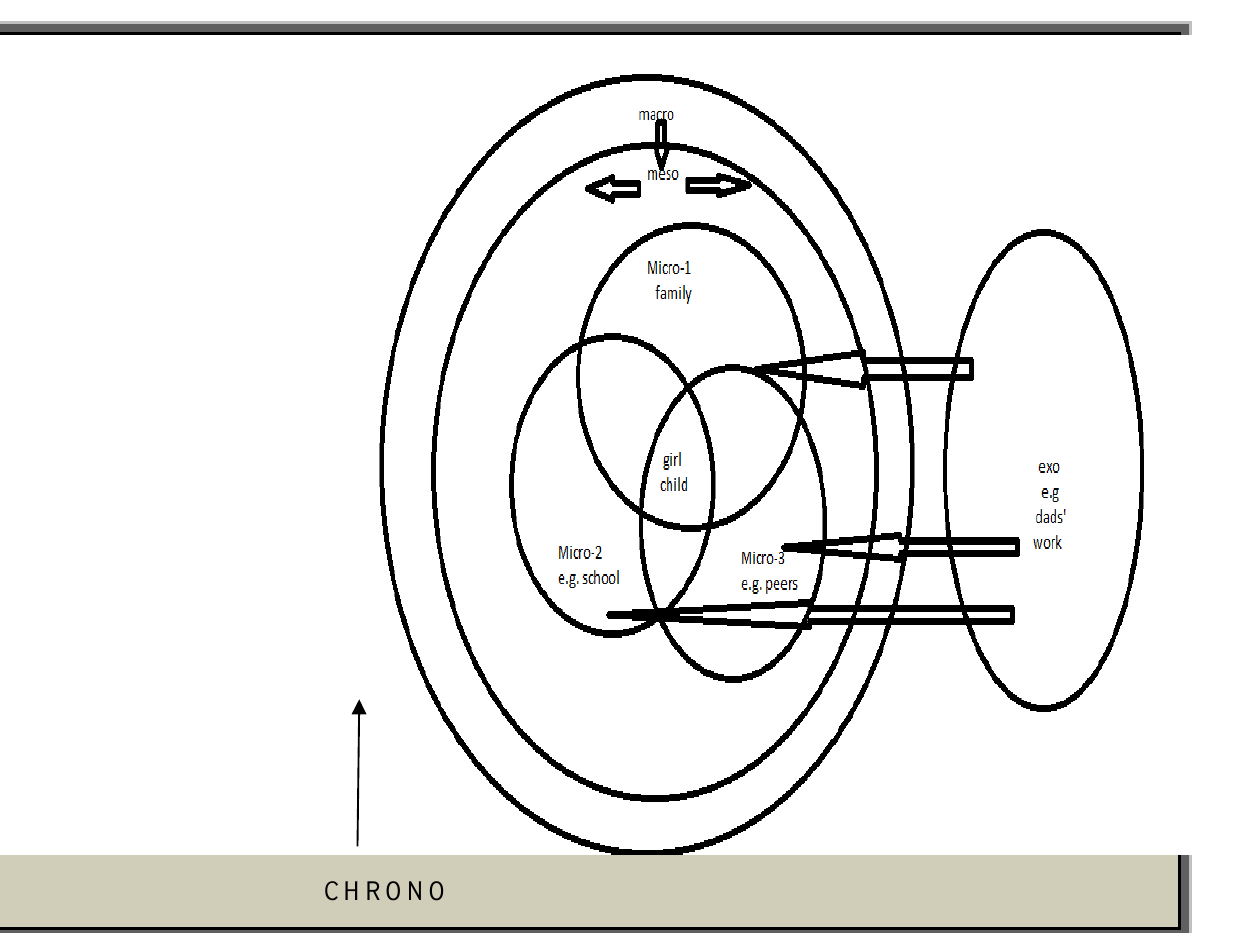
Figure 2.1 Bronfenbrenner’s nested system (Donald, et al.